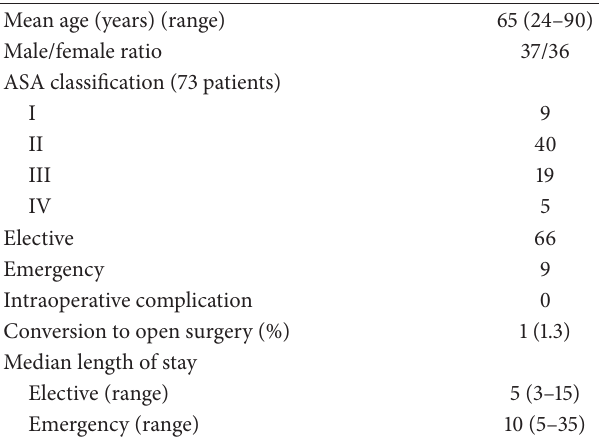
Table 1: Summary of baseline demographics and clinical character- istics of 73 patients undergoing 75 laparoscopic large bowel or rectal resections.